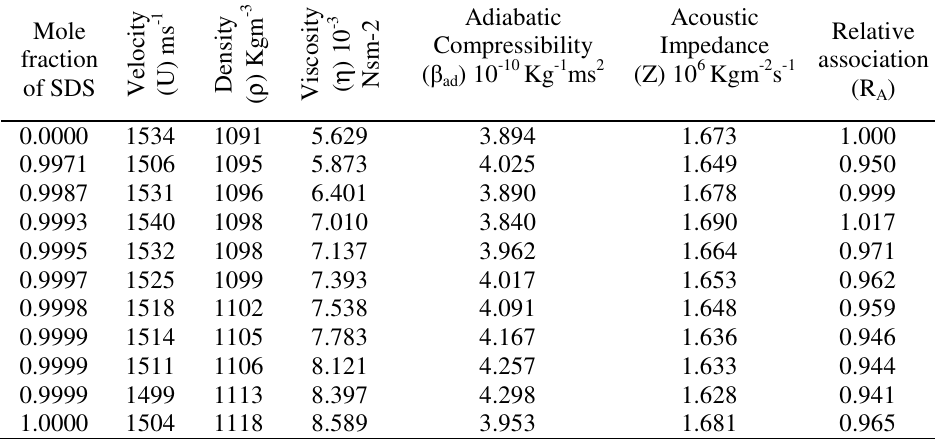
), relaxation time ( τ ), f and internal pressure ( π ) of sodium dodecyl sulphate (SDS) class i